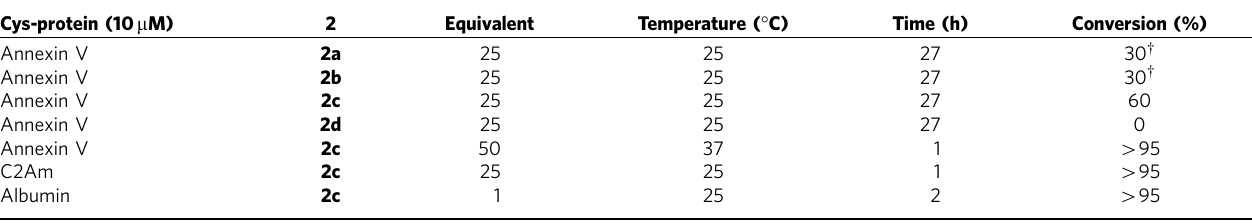
Table 1 | Cys-bioconjugation on